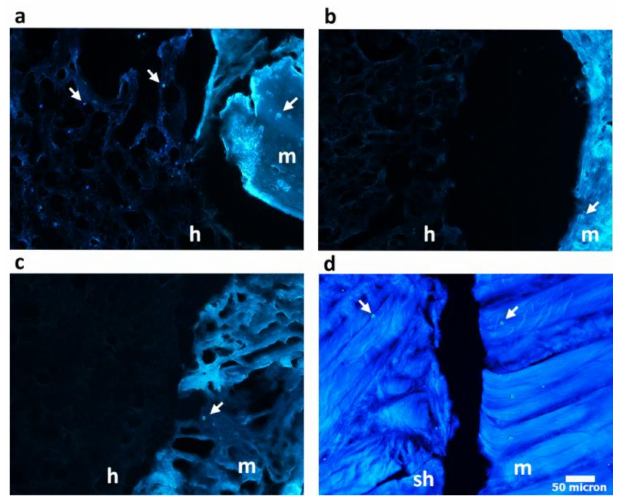
Figure 8. DAPI staining on histological sections representing nuclei (indicated by white arrows) of meniscus cells at the junctions level between the meniscal explants and the gelatin/PVA porous hydrogel ( a ), PVA porous hydrogel ( b ), non-porous gelatin/PVA hydrogel ( c ), sham ( d ) after 10 days of ex vivo culture. Meniscal explants (m), hydrogels (h) and the sham (sh) are indicated in the